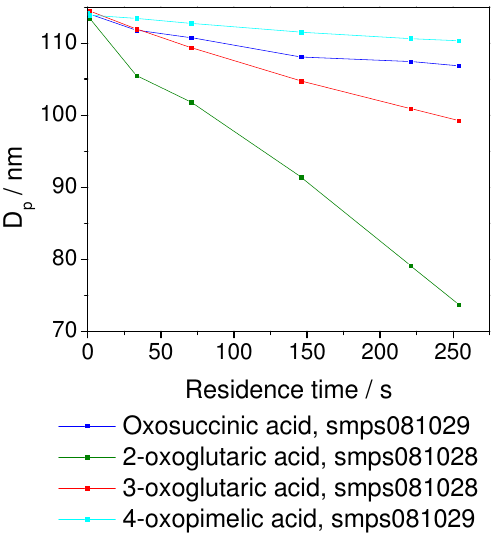
Fig. 11. Examples of evaporation rates of the four oxo-acids in- vestigated in this study. The data points of each evaporation curve represent the particles size measured with a SMPS at the outlet of the first DMA at the entrance of the flow-tube, at four consecutive ports along the length of the flow-tube, and at the end of it. The connecting lines are to guide the